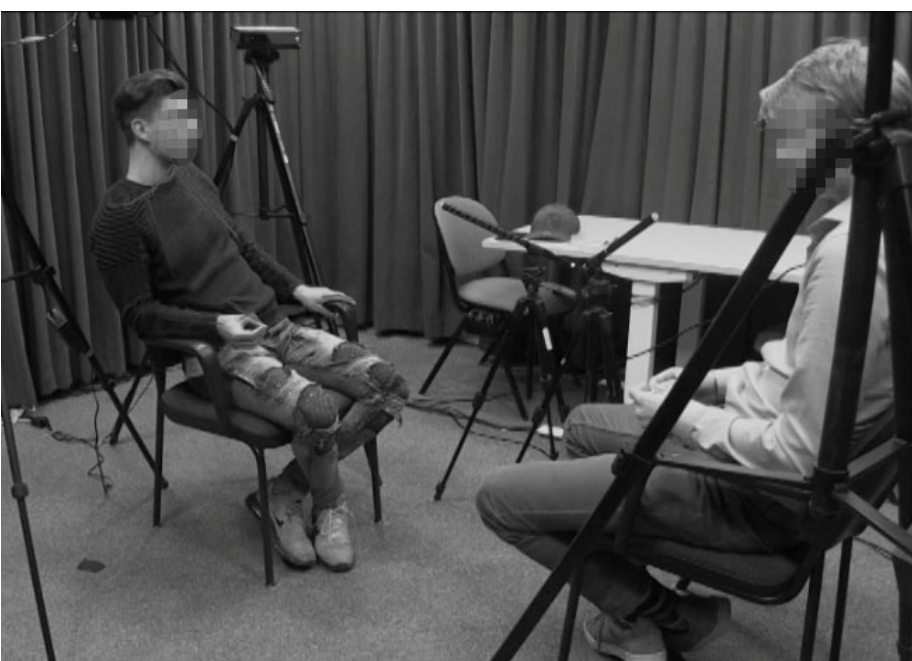
Figure 1. View of recording set-up as seen from participant A’s (left) camera. Visible in this still frame is also one of the Microsoft Kinects, behind participant A’s left shoulder, as well as the tripods for two of the other Kinects, and the two microphones (center).